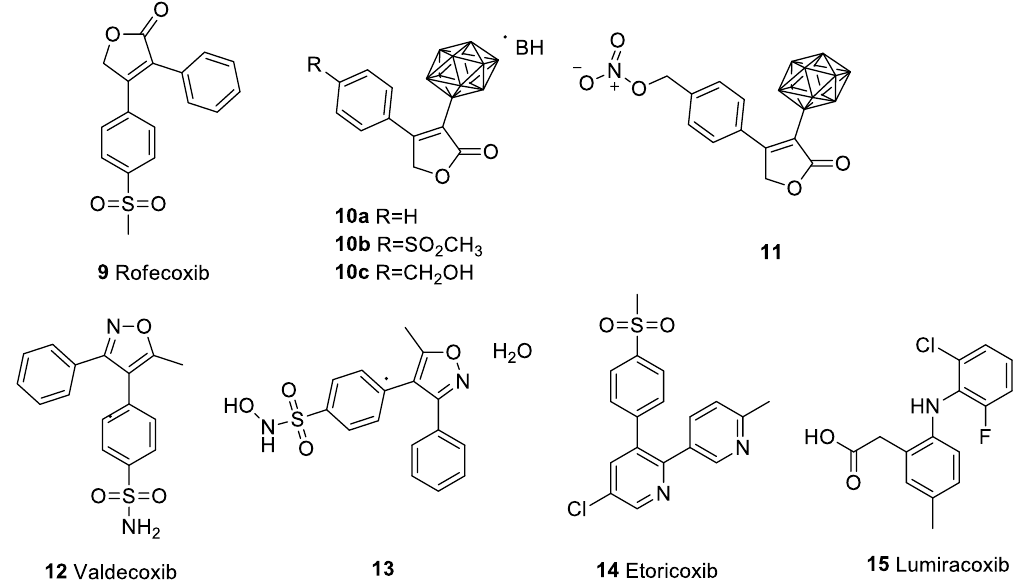
Figure 3. Structure of rofecoxib ( 9 ) and its derivatives ( 10a – c , 11 ), valdecoxib ( 12 ) and its derivative ( 13 ), etoricoxib ( 14 ), and lumiracoxib ( 15 ).